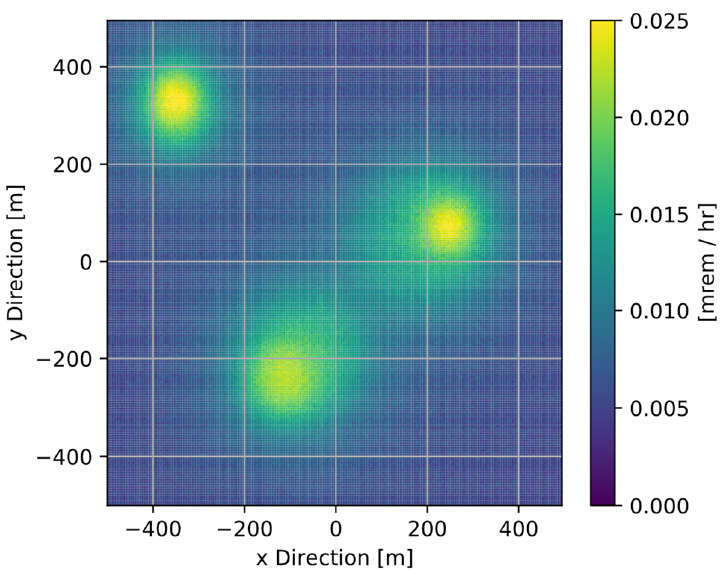
Figure 1. Simulated radiation contamination site showing gamma-ray dose rate distribution. Global average of terrestrial background dose rate is approximately 5.5 × 10 −3 mrem/h.